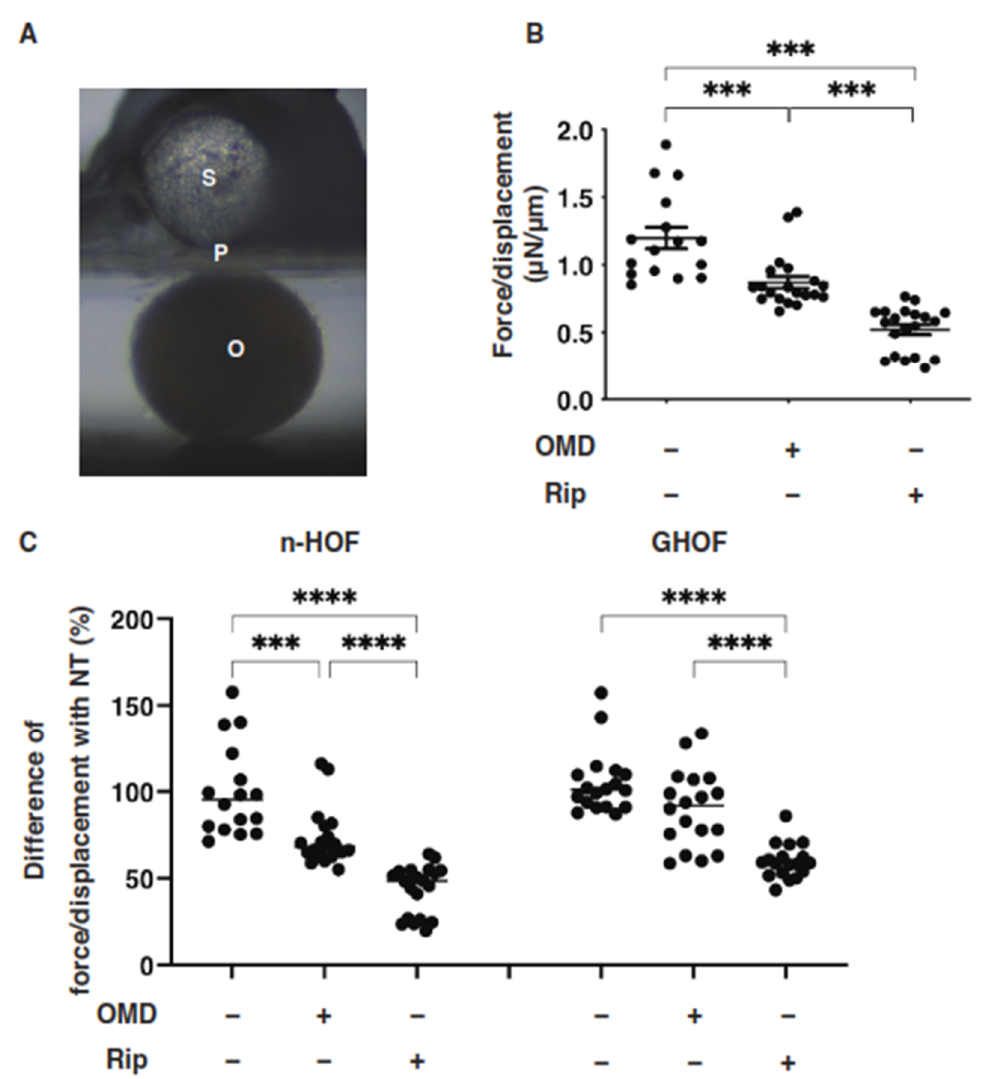
Figure 2. Effects of omidenepag (OMD) or ripasudil (Rip) on the physical stiffness of n-HOFs or GHOF 3D spheroids. At Day 6, the n-HOFs 3D spheroids without or with 100 nM omidenepag (OMD) or 10 µ M Ripasudil (Rip) were subjected to a physical solidity analysis by a micro-squeezer (panel ( A ): S—pressure sensor, P—plate, O—3D HOFs spheroid). The force required to induce deformation until half diameter was reached ( µ N/ µ m force/displacement) was measured and plotted (panel ( B )). Percentage difference in the force/displacement values of n-HOF or GHOF spheroids treated with omidenepag (OMD) or ripasudil (Rip) as above, as compared with their non-treated control (CONT), was plotted (panel ( C ), left). In terms of the results of the GHOF spheroids, the corresponding data reported in our precedent study [11] were recalculated and replotted (panel ( C ), right ). All experiments were performed using freshly prepared 12–20 spheroids. *** p < 0.005, **** p < 0.001 (ANOVA followed by a Tukey’s multiple comparison test).